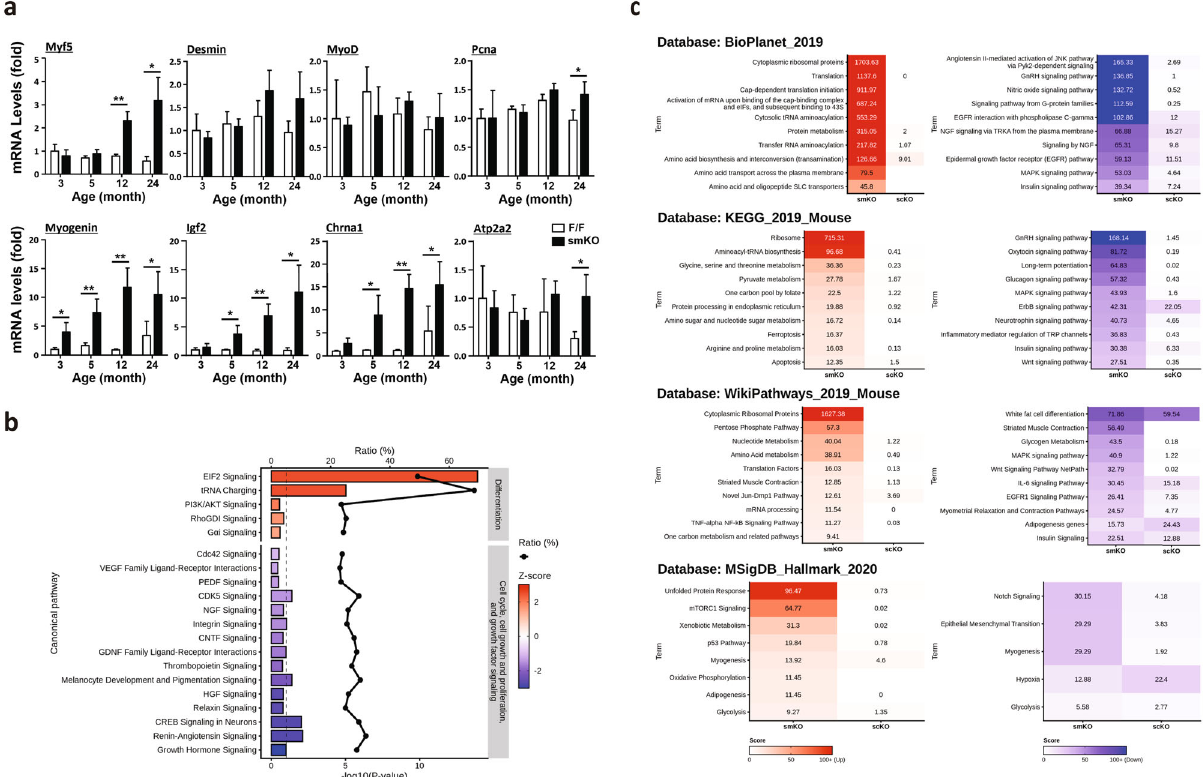
Fig. 5 Rrm2b deletion drives MuSCs toward differentiation but not proliferation. a Quantitative data of mRNA expression of myogenic genes related to quiescence exit, proliferation, and differentiation in skeletal muscles (gastrocnemius) of the Rrm2b smKO mice at ages 3, 5, 12, and 24 months old using RT-qPCR analysis. Five mice were in each group. The data are presented as the mean ± SD. * P < 0.05; ** P < 0.01. b The IPA analysis of RNA sequencing data. The red bar indicates the pathways related to cell differentiation. The blue bar indicates the pathways related to cell proliferation (cell cycle, cell growth and proliferation, and growth factor signaling). The selected pathways had a P -value < 0.05 and Z-score > 1 or < − 1. c Enrichr analysis, including KEGG_2019_Mouse, WikiPathways_2019_Mouse, BioPlanet_2019, and MSigDB_Hallmark_2020. The top pathways were selected. The results were compared to those of the control